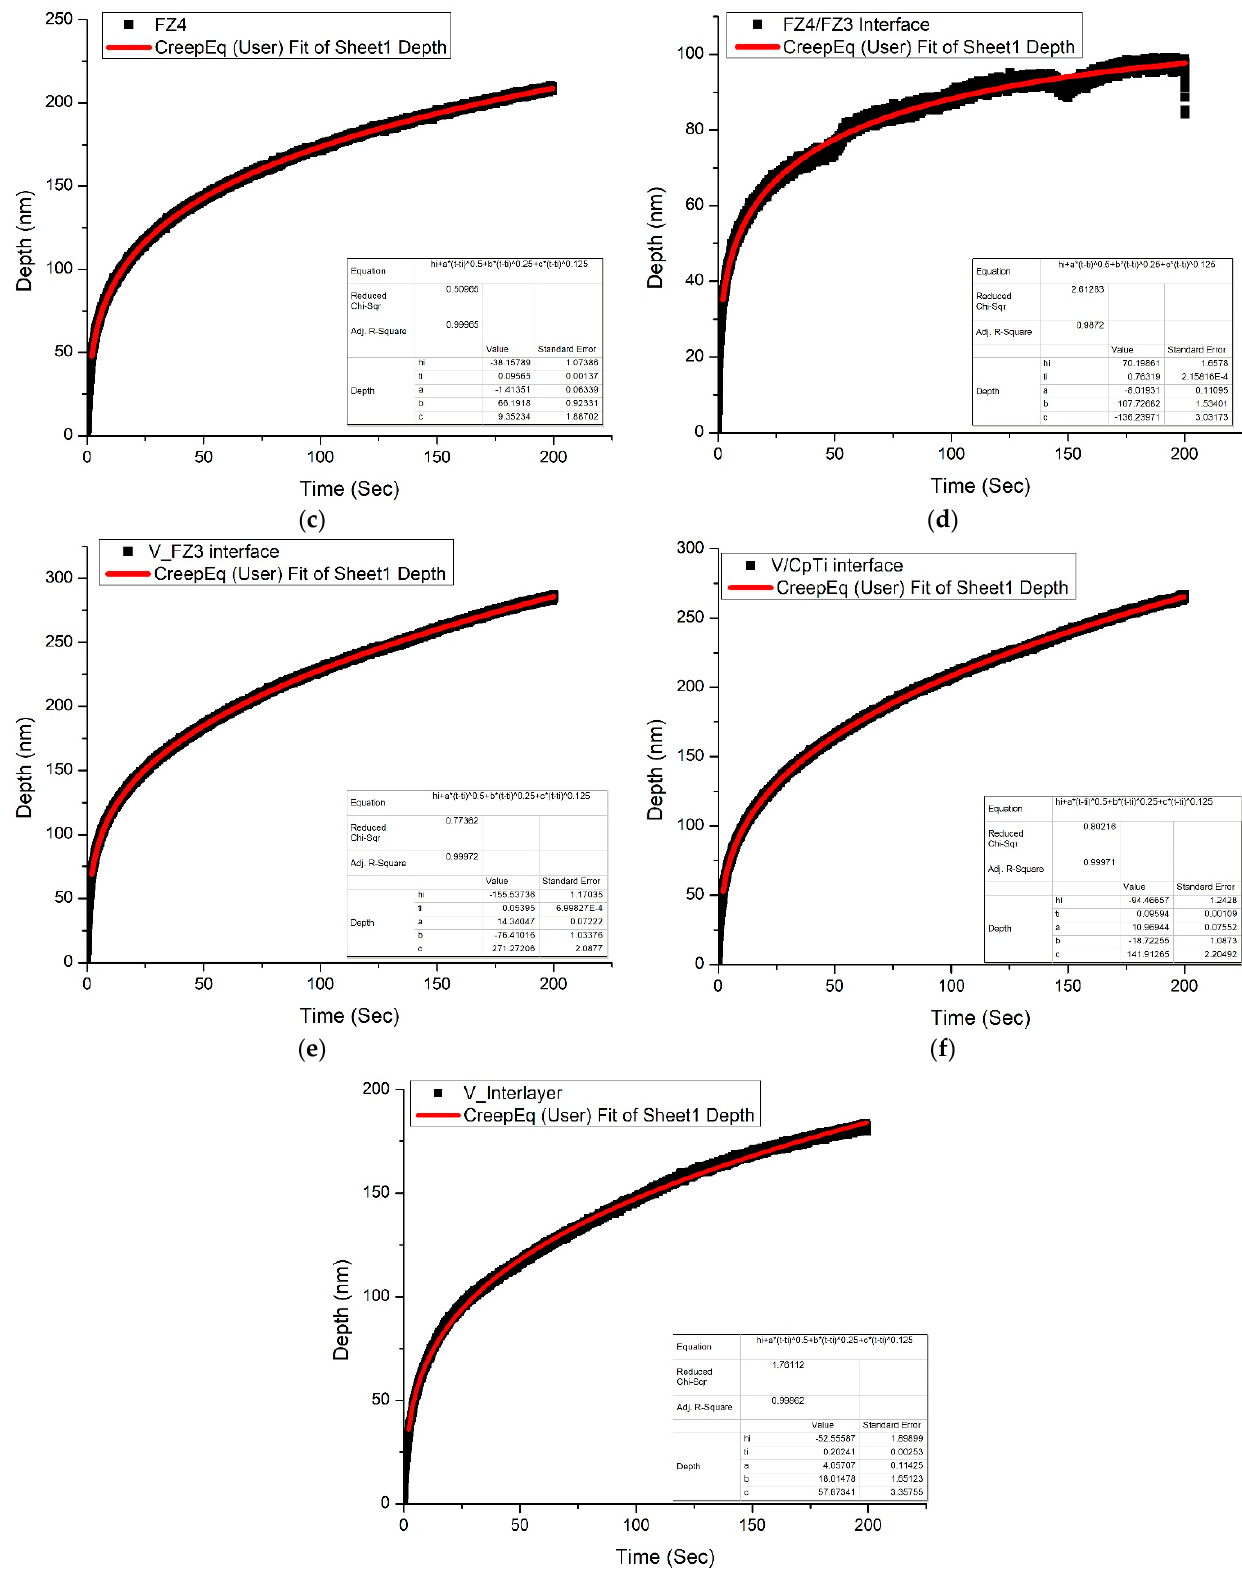
Figure 16. Experimental data and fitted curves for: ( a ) BM of the CpTi side; ( b ) FZ3; ( c ) FZ4; ( d ) the FZ4/FZ3 interface; ( e ) the V/FZ3 interface; ( f ) the V/CpTi interface; and ( g ) the V interlayer. ln (creep strain rate)-ln (stress) are presented in Figure 17a for indentation tests in different regions of the V interlayer and the CpTi side. The slope of the linear function is the creep stress exponent in the linear fitting. Creep stress exponent values indicate a ma- terial's creep behavior in terms of creep resistance and the active creep mechanism. The creep stress exponent of 1 indicates diffusion creep, the creep stress exponent of 2 indi- cates the activation of the grain boundary sliding mechanism, and the creep stress expo- nents of 3 and 4–5 indicate the activation of the viscous motion of dislocations and the dislocation climb mechanism, respectively [44,45]. In addition, the variation in creep stress exponent values implies a change in creep resistance across regions. A higher creep stress exponent value indicates a greater creep resistance [34]. Through calculation, and with the use of Equation (7), the stress exponent in the V interlayer, the V/CpTi interface, FZ4 and BM (CpTi) was found to be less than 2, as shown in Figure 17b. As a result, the active creep mechanism in these regions is a diffusional one. This could be due to the diffusion of vacancies, that caused plastic deformation of the material over time. The creep behavior of the Inconel 617 top layer was investigated by Salari et al. [46] and the diffusion was found to be the active creep process with a creep stress exponent of less than 2 at ambient temperature. However, the creep mechanism at the interfaces of V/FZ3 and FZ4/ FZ3, with higher creep stress exponents (2.17 and 2.88), might be caused by the grain boundary sliding. Similar plastic deformation by the grain boundary sliding mechanism at the interfaces in nanocyrstalline FCC metals is reported [47]. Moreover, a stress exponent in the FZ3 region greater than 3 represents a dislocation climb mechanism showing the highest creep resistance over all the regions.